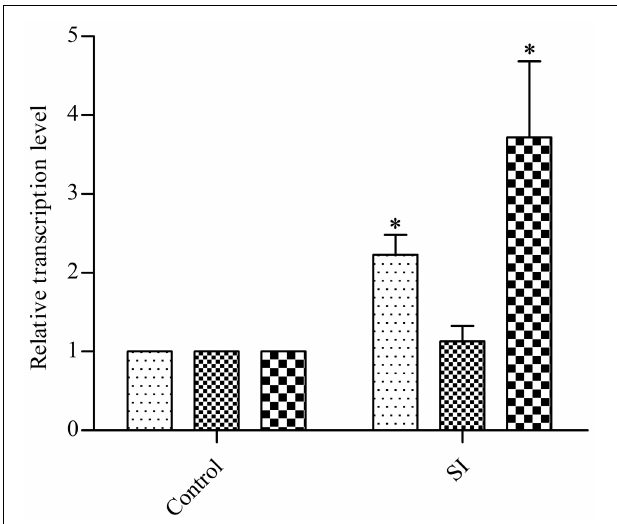
FIGURE 2 | Effects of a sub-inhibitory dose of EGCG on the transcription levels of cell-wall-related genes. As a control, cells without EGCG treatment were cultured until OD 600 reached 0.5. y axis represents comparative critical threshold values obtained after normalizing data against 16S rRNA gene. All values were obtained from at least three biological replicates. Error bars indicate SD. ∗ P < 0.05.